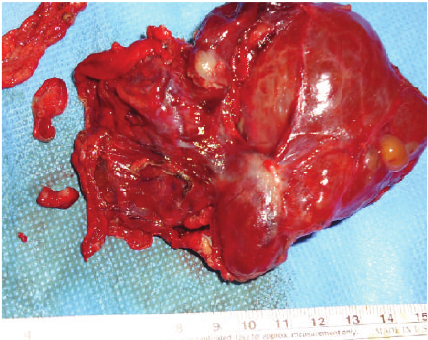
Figure 4: Total excision of the retroperitoneal